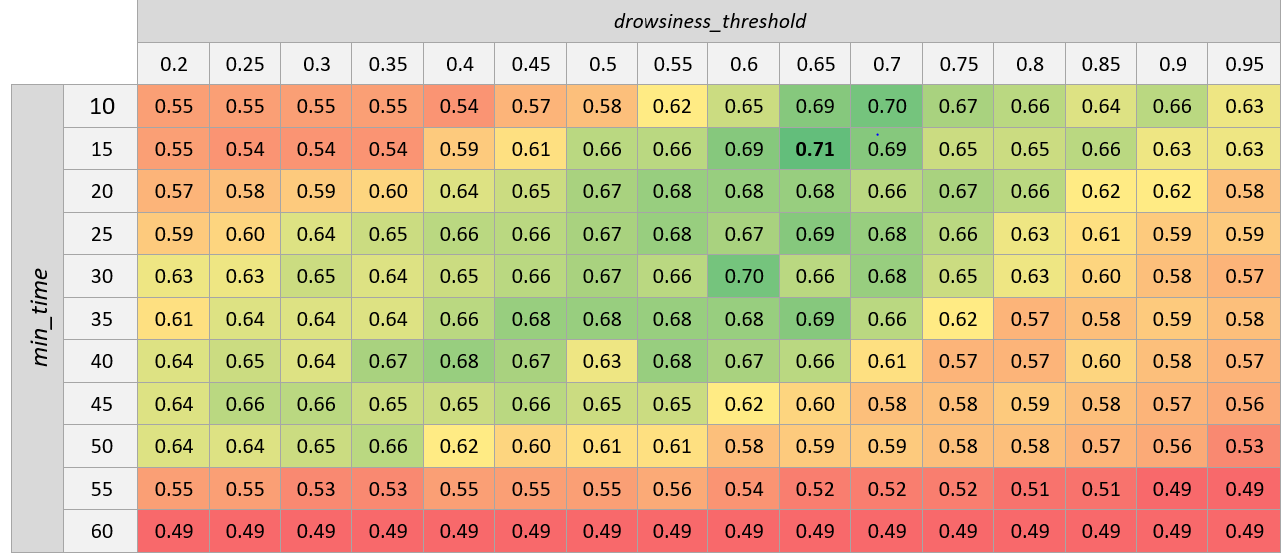
Figure 11. Accuracy obtained by Alternative I over training data. Minimun value is colored red. Median value is colored yellow. Maximum value is colored green. All other cells are colored proportionally. The best value is shown in